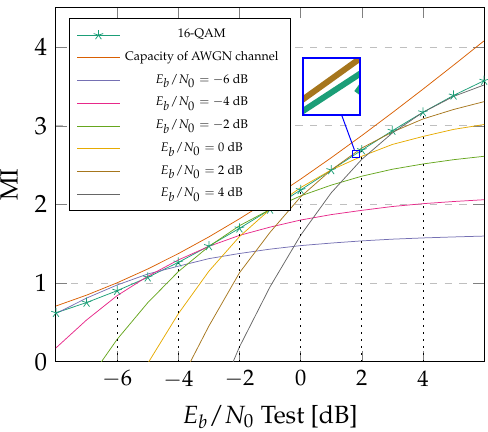
Figure 5. MI of autoencoder constellations compared to channel capacity and